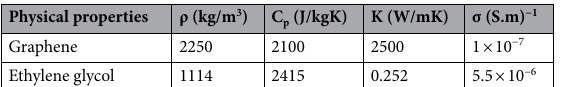
Table 2. Thermo-physical attributes of ethylene glycol and